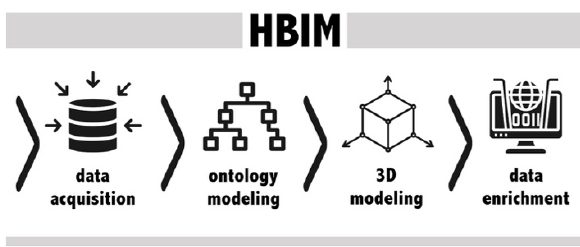
Figure 2. The research workflow (© authors).